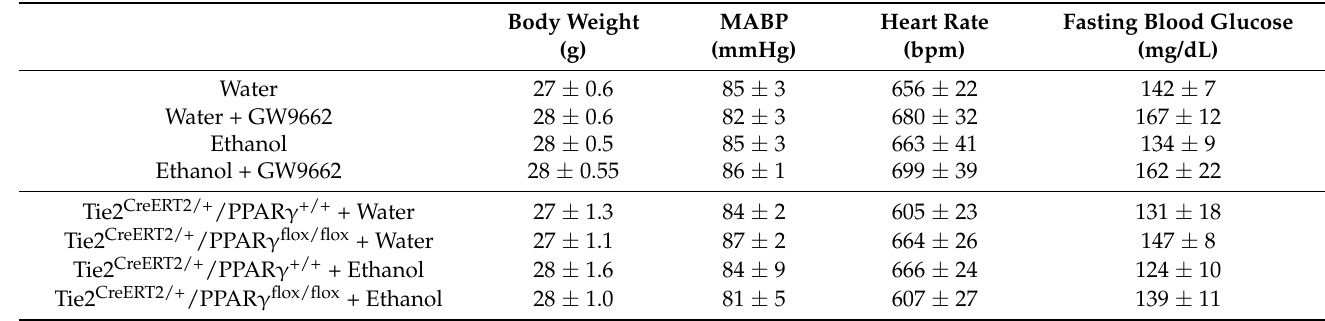
Table 1. Physiological